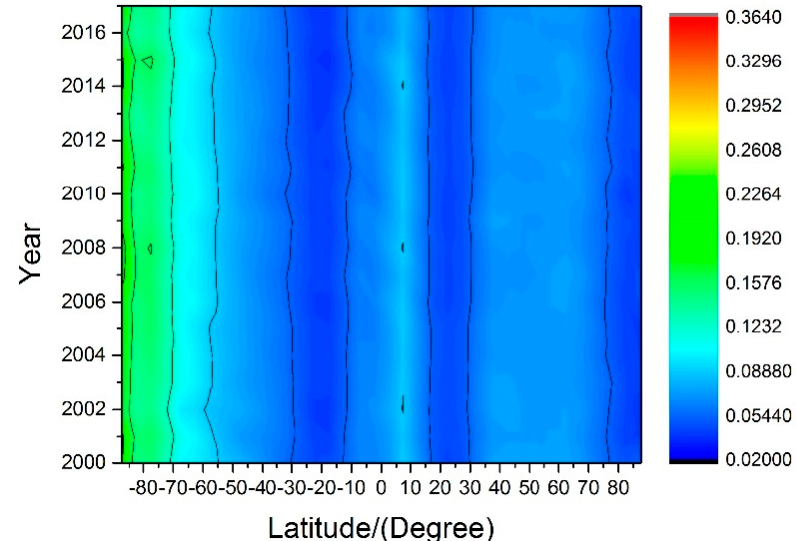
Figure 4. The variations of the yearly-average cirrus reflectance vs. latitude from 2000 to 2017.